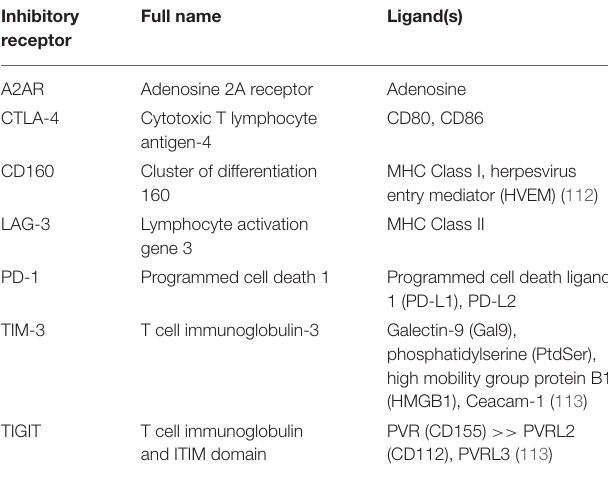
TABLE 2 | Some inhibitory receptors and their known ligands [from Wherry et al. (111), unless cited in table]. Inhibitory